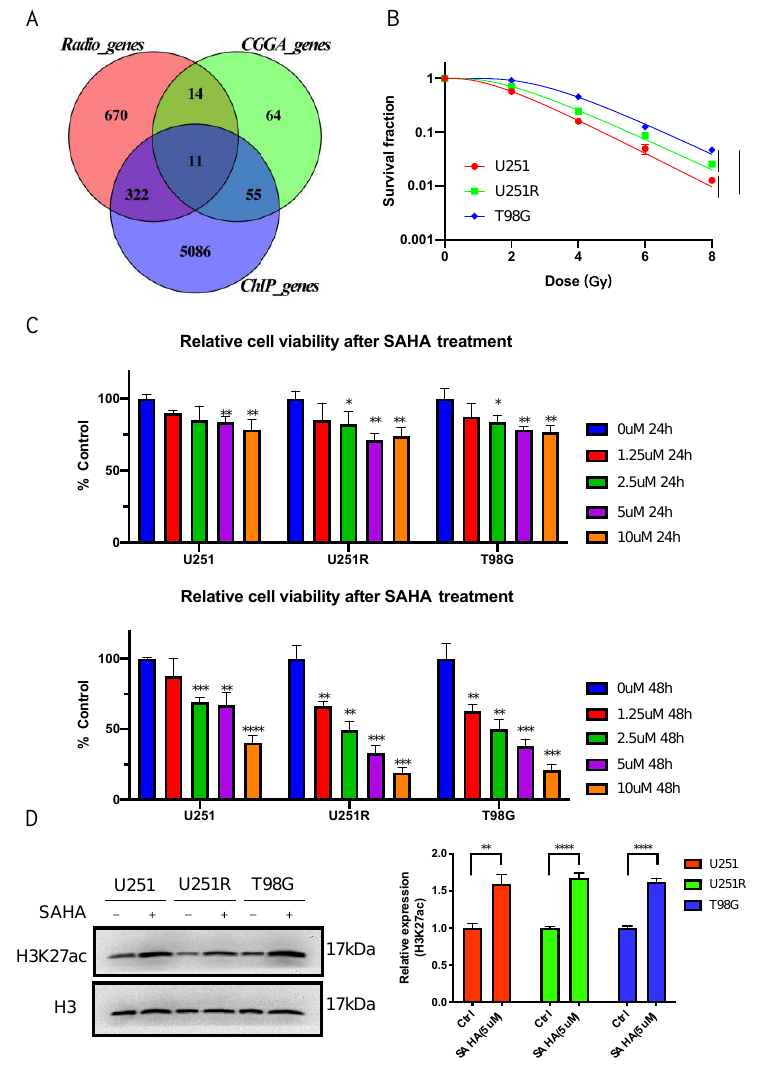
Figure 4. The effect of SAHA on H3K27ac levels in GBM cells. ( A ) Venn diagram illustrating the intersections of three candidate genes: “Radio_genes”, “CGGA_genes”, and “ChIP_genes”. ( B ) Colony formation assay of the survival curves of U251, U251R, and T98G cells irradiated with different doses of X-rays. ( C ) Cytotoxicity of SAHA treatment for 24 h and 48 h to three GBM cell lines. ( D ) Western blot assay of H3K27ac proteins in U251, U251R, and T98G cells after SAHA treatment. * p < 0.05, ** p < 0.01, *** p < 0.001, **** p < 0.0001. Abbreviations: CGGA, Chinese Glioma Genome Atlas; ChIP, chromatin immunoprecipitation; H3K27ac, histone H3 lysine 27 acetylation; TSS, transcription start site; SAHA, suberoylanilide hydroxamic acid; IR, irradiated; Ctrl,